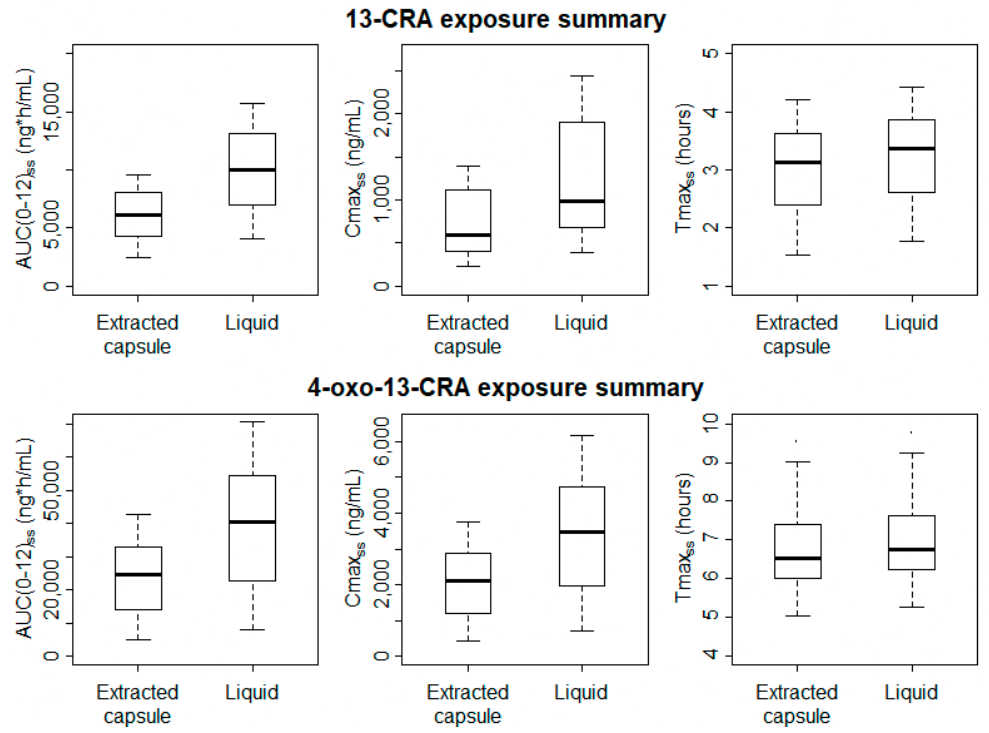
Figure 3. The plots above compare the individual model-predicted AUC (0-12)ss , Cmax ss and Tmax ss (left-to-right) of 13-CRA (upper panel) and 4-oxo-13-CRA (lower panel). Individual values are summarized as vertical box-and-whisker plots, with the box covering the interquartile range (IQR), the median shown by the thick black line and with whiskers extending to 1.5 times the IQR.